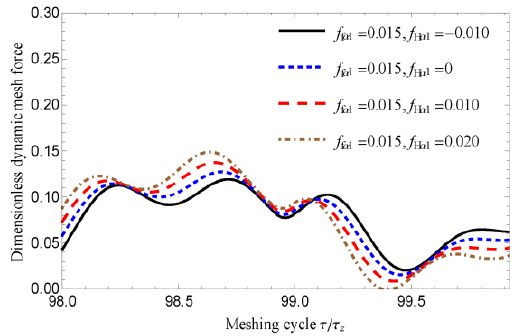
Figure 15. Total dynamic mesh force under different 𝑓 𝐻𝛼1 .